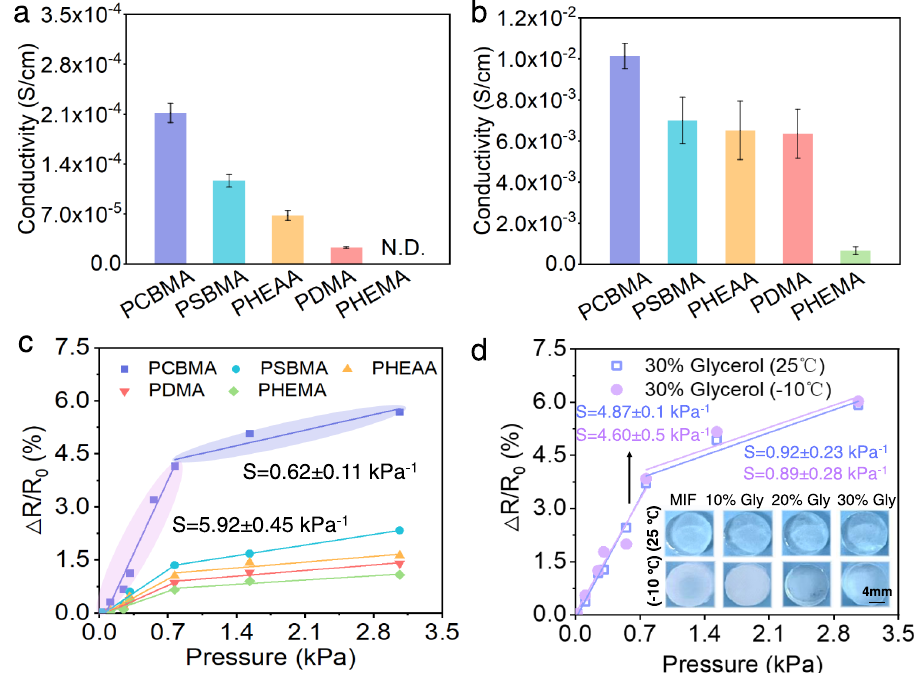
Fig. 3 | Conductivity and Sensitivity of the hydrogels. a Ionic conductivities of thehydrogelsinthemobile-ion-freeand b mobile-ion-addedsystems,respectively. Data are reported astheir means±SDs ( N ≥ 3). N.D. not detected. c Comparison of hydrogel sensitivities. The correlation coef fi cients of the high-sensitivity and low- sensitivity phases of the PCBMA hydrogel are R 2 =0.968 and R 2 =0.906,